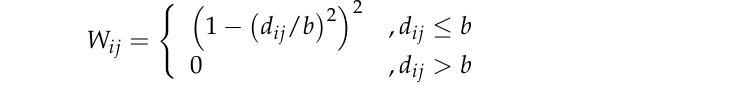
Figure 4. Evolution and decomposition of wheat yield differences in different cultivation areas in the HHH region. ( I ) Hebei, Shandong, and Henan low-lying plains. ( II ) pre-mountain plain area in Yanshan and Taihang Mountains. ( III ) Huang-Huai plain area. ( IV ) Shandong hilly area. Figure 4 shows that the differences in wheat production in zones II, III and IV are consistent, and they all experienced a process of gradually narrowing. Only the wheat difference in zone I showed a V-shaped trend with 2017 as the lowest point. Contributions to the overall variance vary by district: From a lateral perspective, zone I contributed the most to the overall difference in the HHH, with an average contribution of 54.47%, fol- lowed by zones IV and III, and zone IV had the lowest contribution rate (below 15%). From a longitudinal perspective, the internal differences between zones I and II gradually increased, which together led to an increase in the contribution of regional differences to the overall differences from 70.79% to 74.10%. The internal differences between zones III and IV gradually decreased, which together led to an increase in the contribution of re- gional differences to the overall differences from 29.21% to 25.90%. 3.1.2. Spatial Distribution According to Equations (4)–(5), the spatial agglomeration of wheat yield was visually analyzed. In Figure 5, ’ 0 Moran s I > , all years pass the significance test, and the two